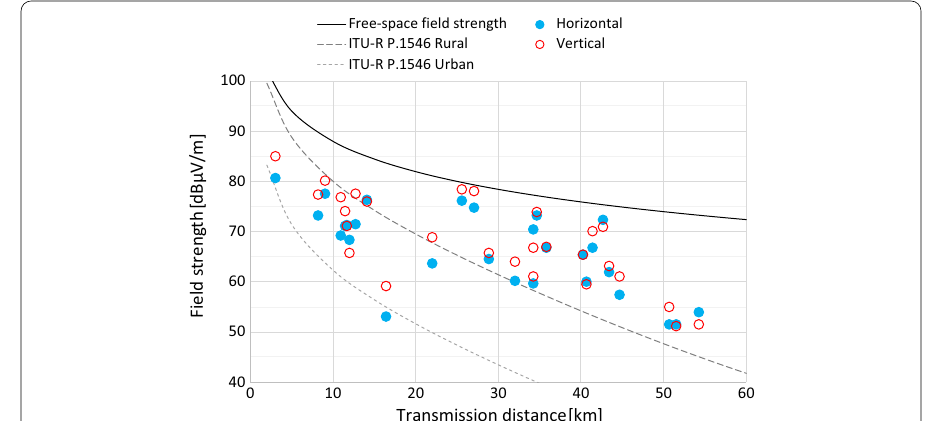
Fig. 12 Field strength measured in field